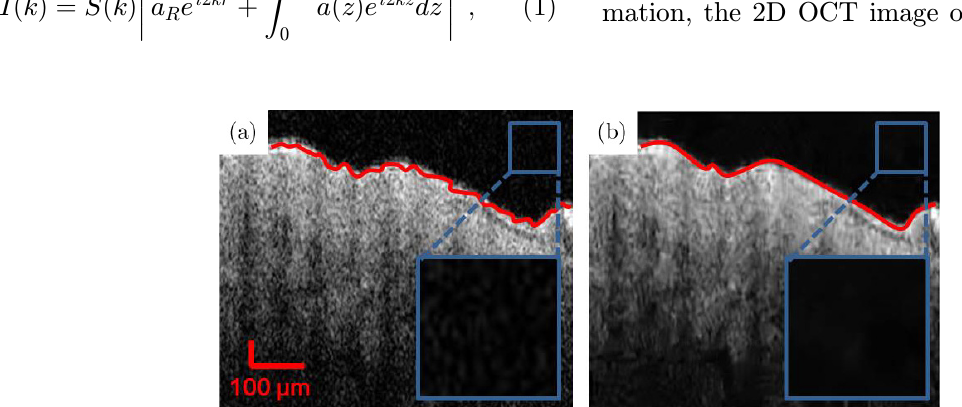
Fig. 3. 2D OCT image of skin before (a) and after (b) denoising by BM3D. (The margins of skin images were marked by red solid lines, and the background noise in ROIs were marked by blue solid